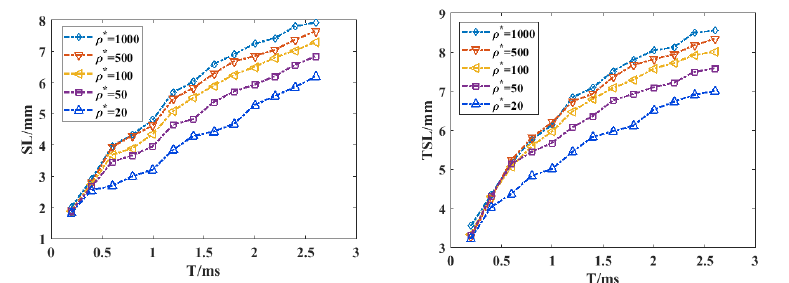
Figure 14. Spreading length at different density ratio when θ = 30 ◦ .